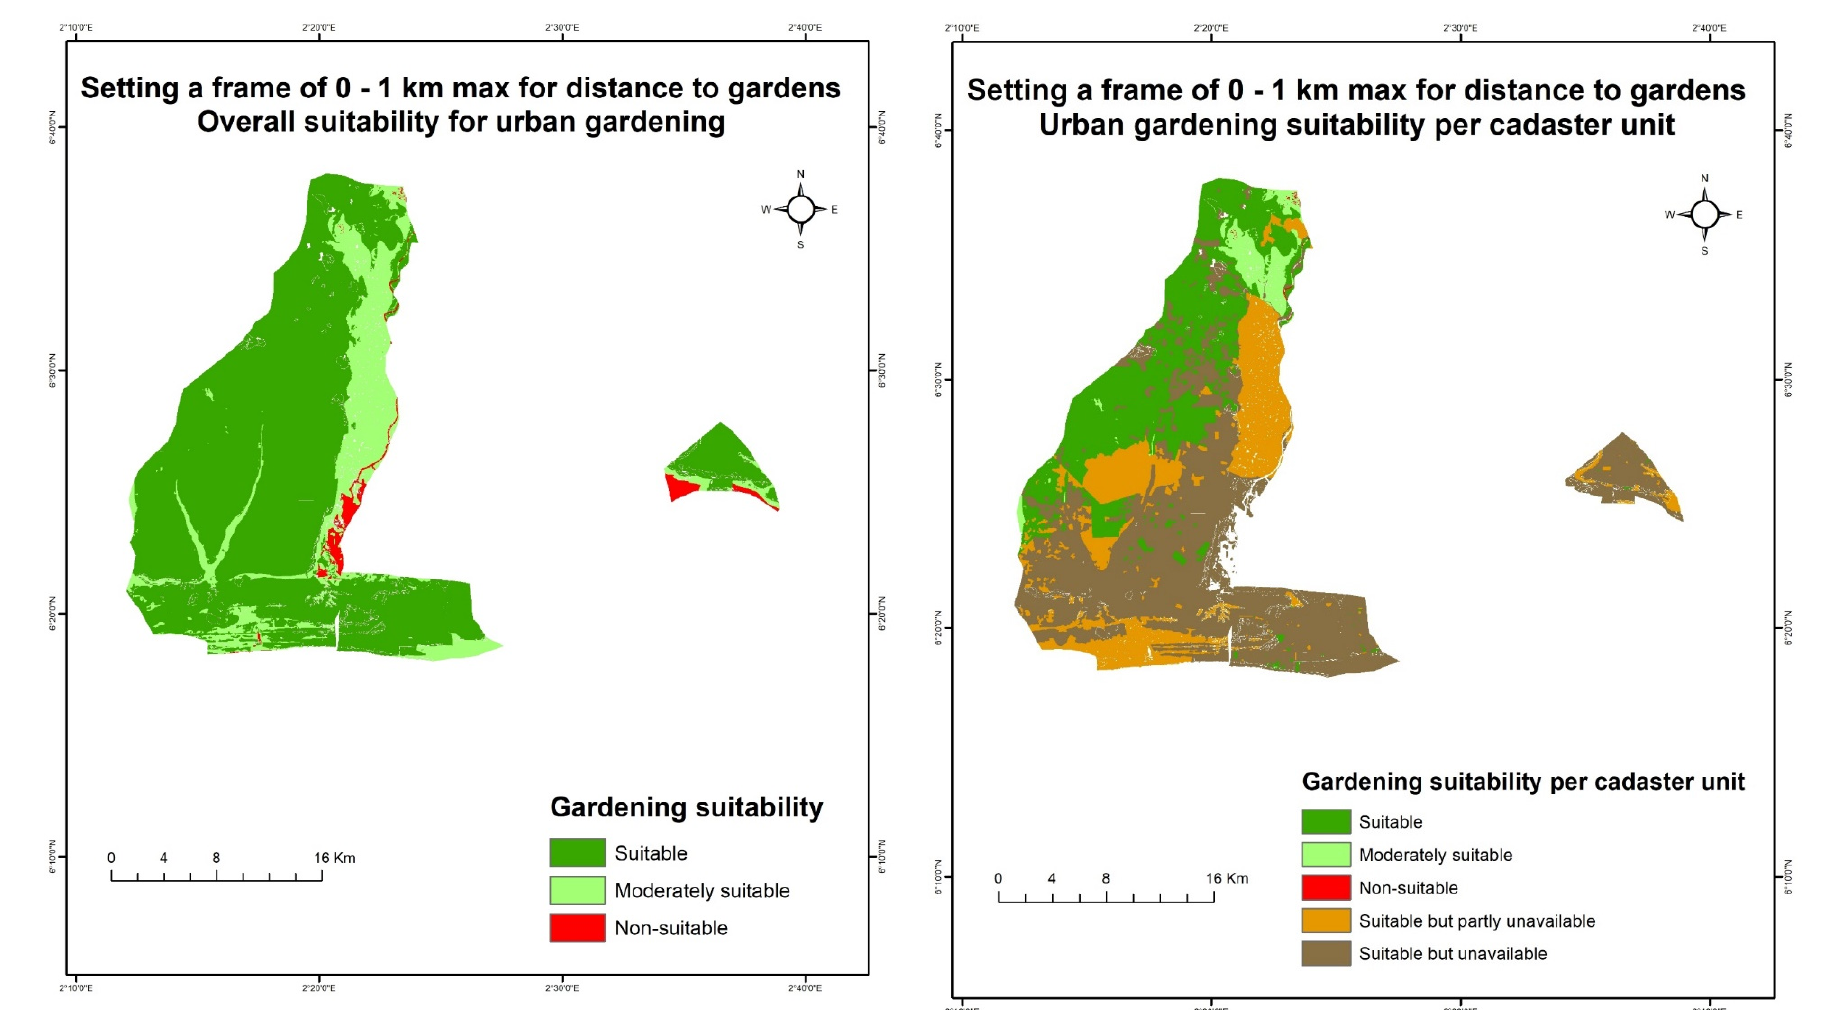
Figure 5. Classified maps of suitable areas for urban gardening: first safety improvement scenario. 1